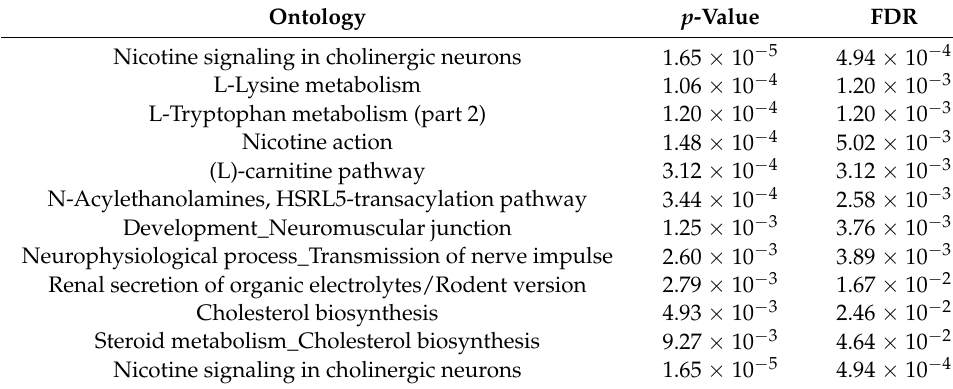
Table 4. Ontologies diminished by Hemangiosarcoma vs.